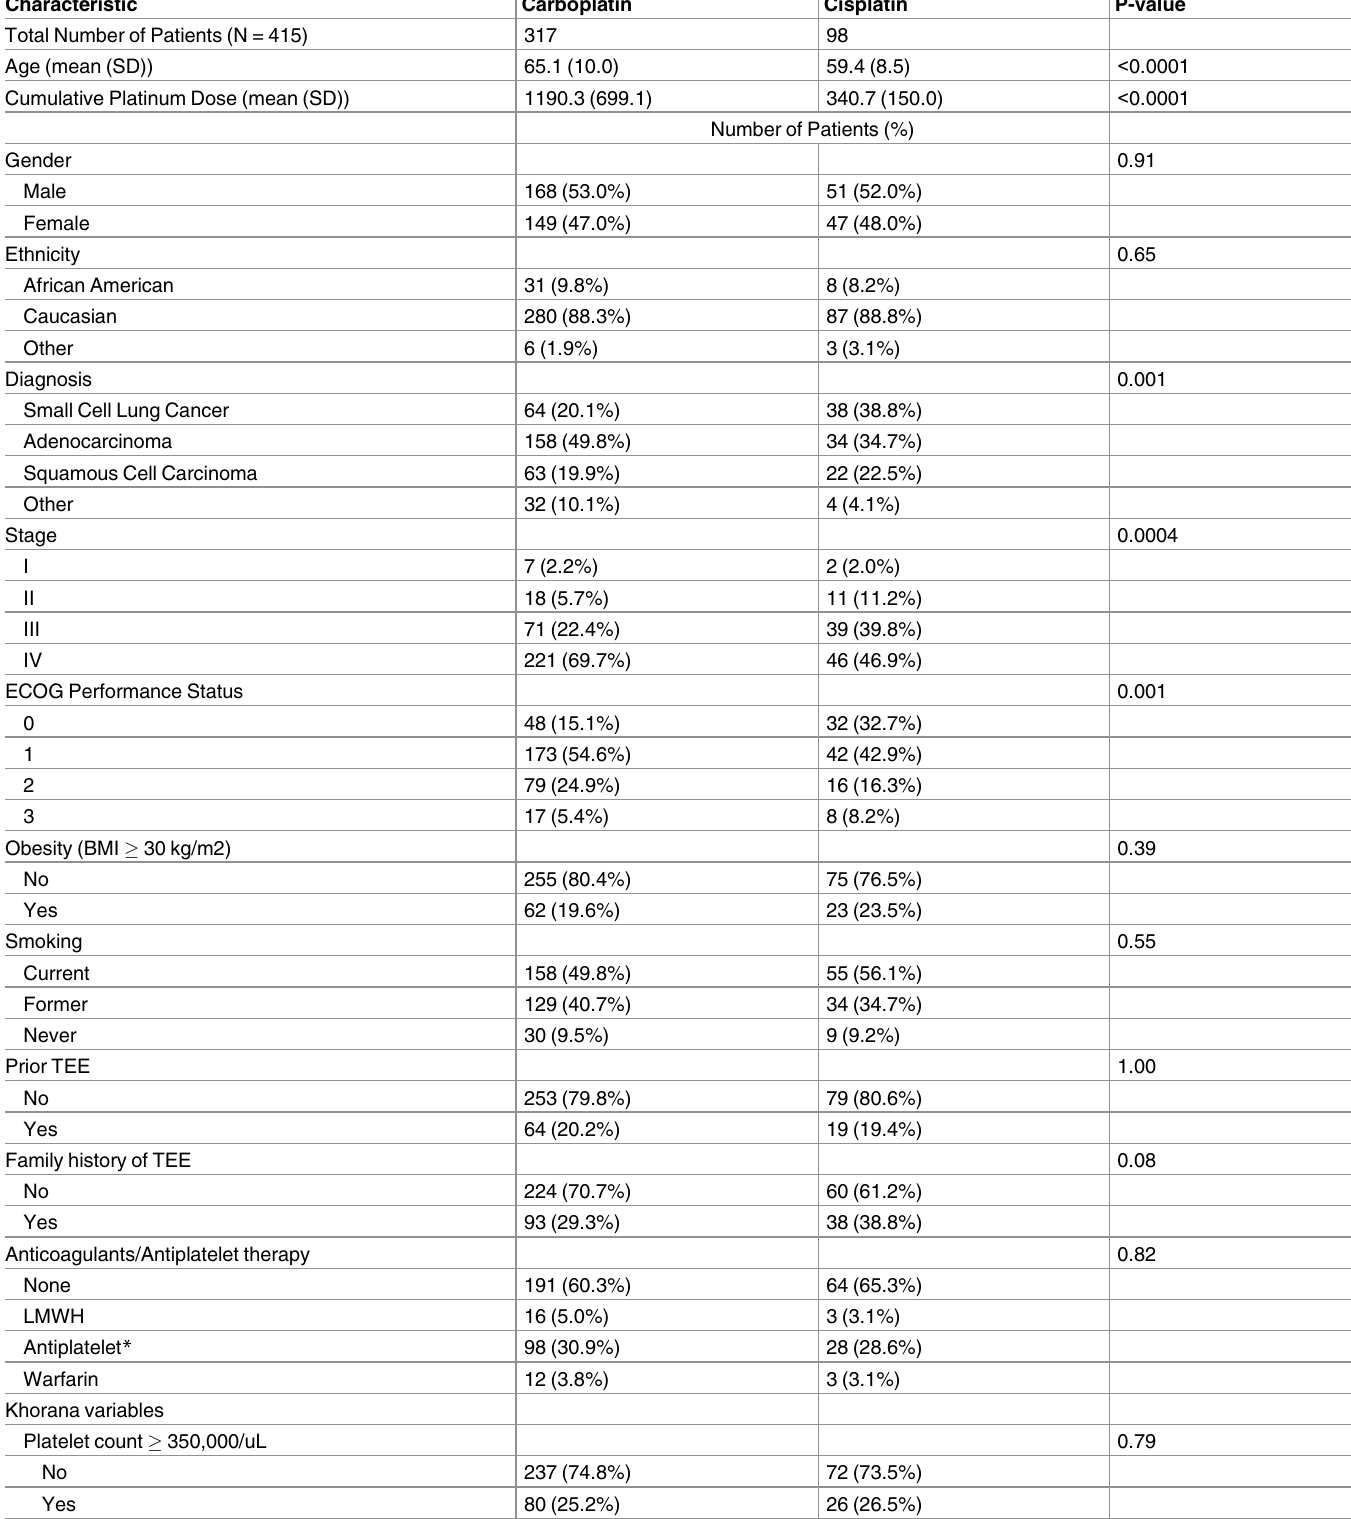
Table 1. Patient characteristics categorized by carboplatin and cisplatin